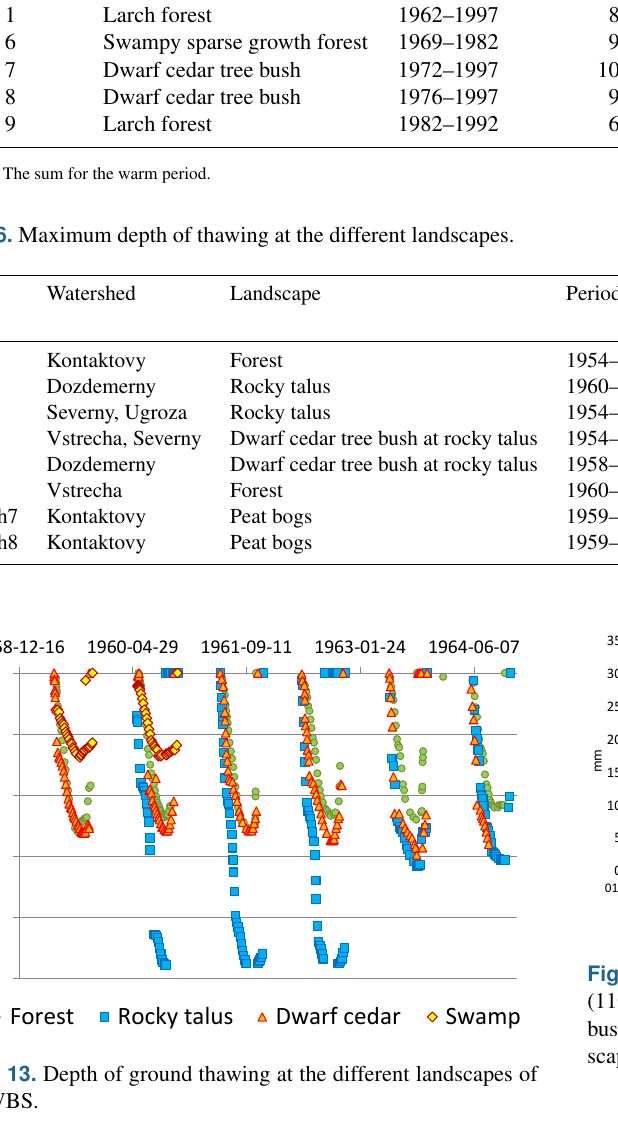
Table 5. Mean evapotranspiration (mm) from June to September at different landscapes of the KWBS. n/a – not applicable. Site no.